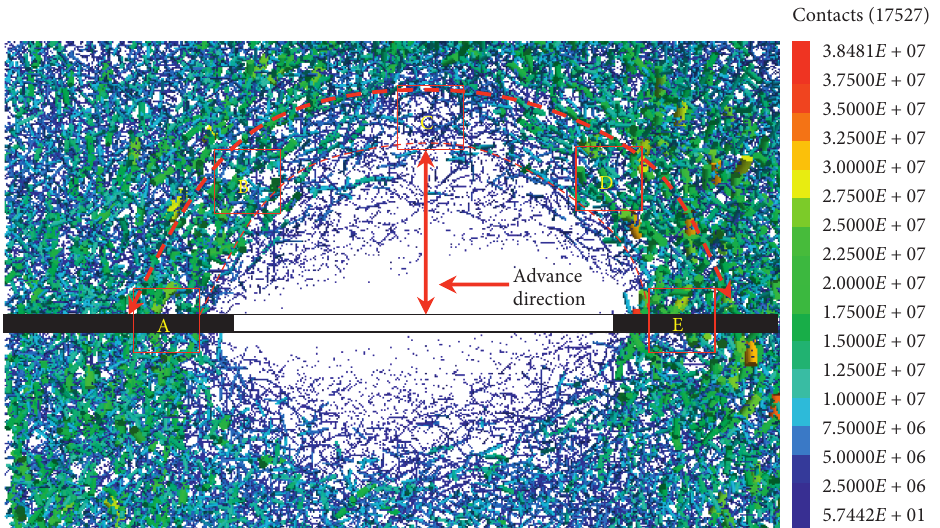
Figure 8: Distribution characteristics of the strike force chains of the surrounding rock masses in the